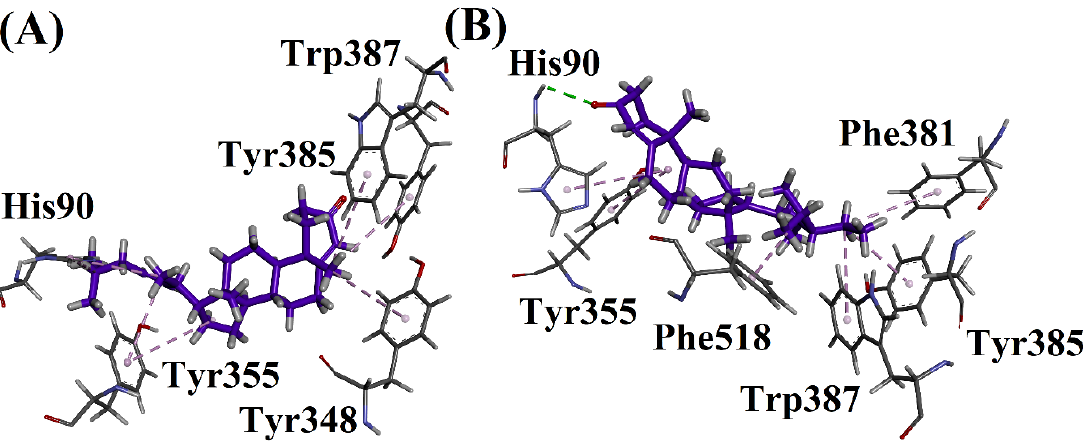
Figure 6. ( A ) Interactions of compound 1 and ( B ) Interactions of compound 2 in 6N2W active site. 2.6.3. Docking on 1EQG (COX-1) The docking studies of isolated compounds on the COX-1 target were performed as shown in Figure 2. The protein structure from the protein data bank was obtained with code 1EQG, and both compounds were docked into the minimized pocket of the target protein. Compound A showed a π -lone pair interaction with Tyr385 and a π -alkyl inter- action with Trp387, Phe518 and Tyr355. Compound B showed a triple π -alkyl interaction with Tyr355. 2.6.4. Docking on COX 2 Site Compound 1 showed a π -alkyl interaction with His90, Trp355, Tyr348, Tyr385 and Trp387. Compound 2 showed a conventional hydrogen bonding interaction with His90 and a π -alkyl interaction with Tyr355, Phe518, Trp387, Tyr385, Phe381 and His90. 2.6.5. Docking on 6N2W_(5-LOX) Compound 1 showed a conventional hydrogen bonding interaction with Arg596 and also showed a π -alkyl interaction His372 and His432. Compound 2 showed a conventional hydrogen bonding interaction with Arg596. The same compound showed a π -alkyl inter- action with Trp599, His367 and His372.